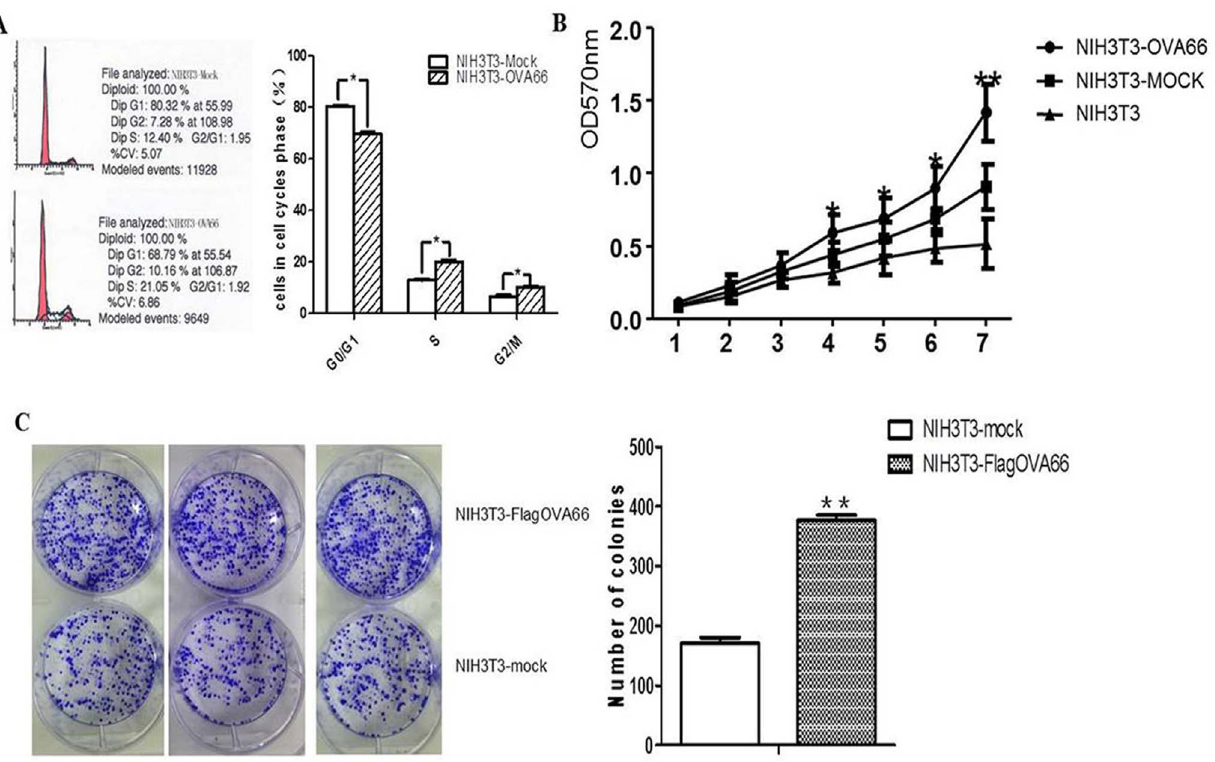
Figure 2. FACS, MTT, and colony-formation assays of NIH3T3-flagOVA66 and NIH3T3-mock cells. A. FACS analysis of cell cycle of the two transfected NIH3T3 cells. OVA66 overexpression in NIH3T3-flagOVA66 cells significantly promote cell cycling compared with NIH3T3-mock cells. B. OVA66 overexpression promoted proliferation of NIH3T3-flagOVA66 cells in vitro . Proliferation of NIH3T3 and NIH3T3 transfected with pFlag-OVA66 and pFlag-vector were analyzed by MTT assay for 7 days. C. Colony formation assay in 6-well plates. NIH3T3-flagOVA66 and NIH3T3-mock cells were seeded at 0.4 6 10 3 cells per well. After 2 weeks of cultivation, cells were fixed with 4% paraformaldehyde and stained with crystal violet. Numbers of colonies formed by NIH3T3-flagOVA66 and NIH3T3-mock were calculated. The data are represented as mean 6 SEM (n=3), * P # 0.05, ** P # 0.01.